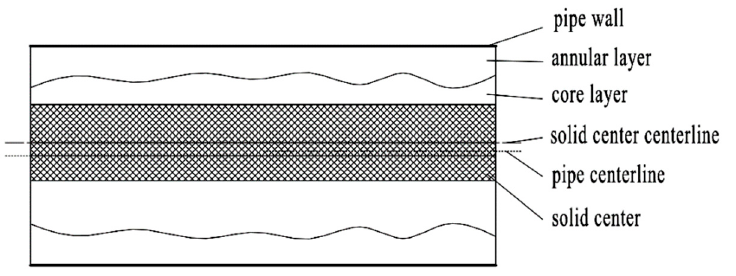
Figure 10. Flow model